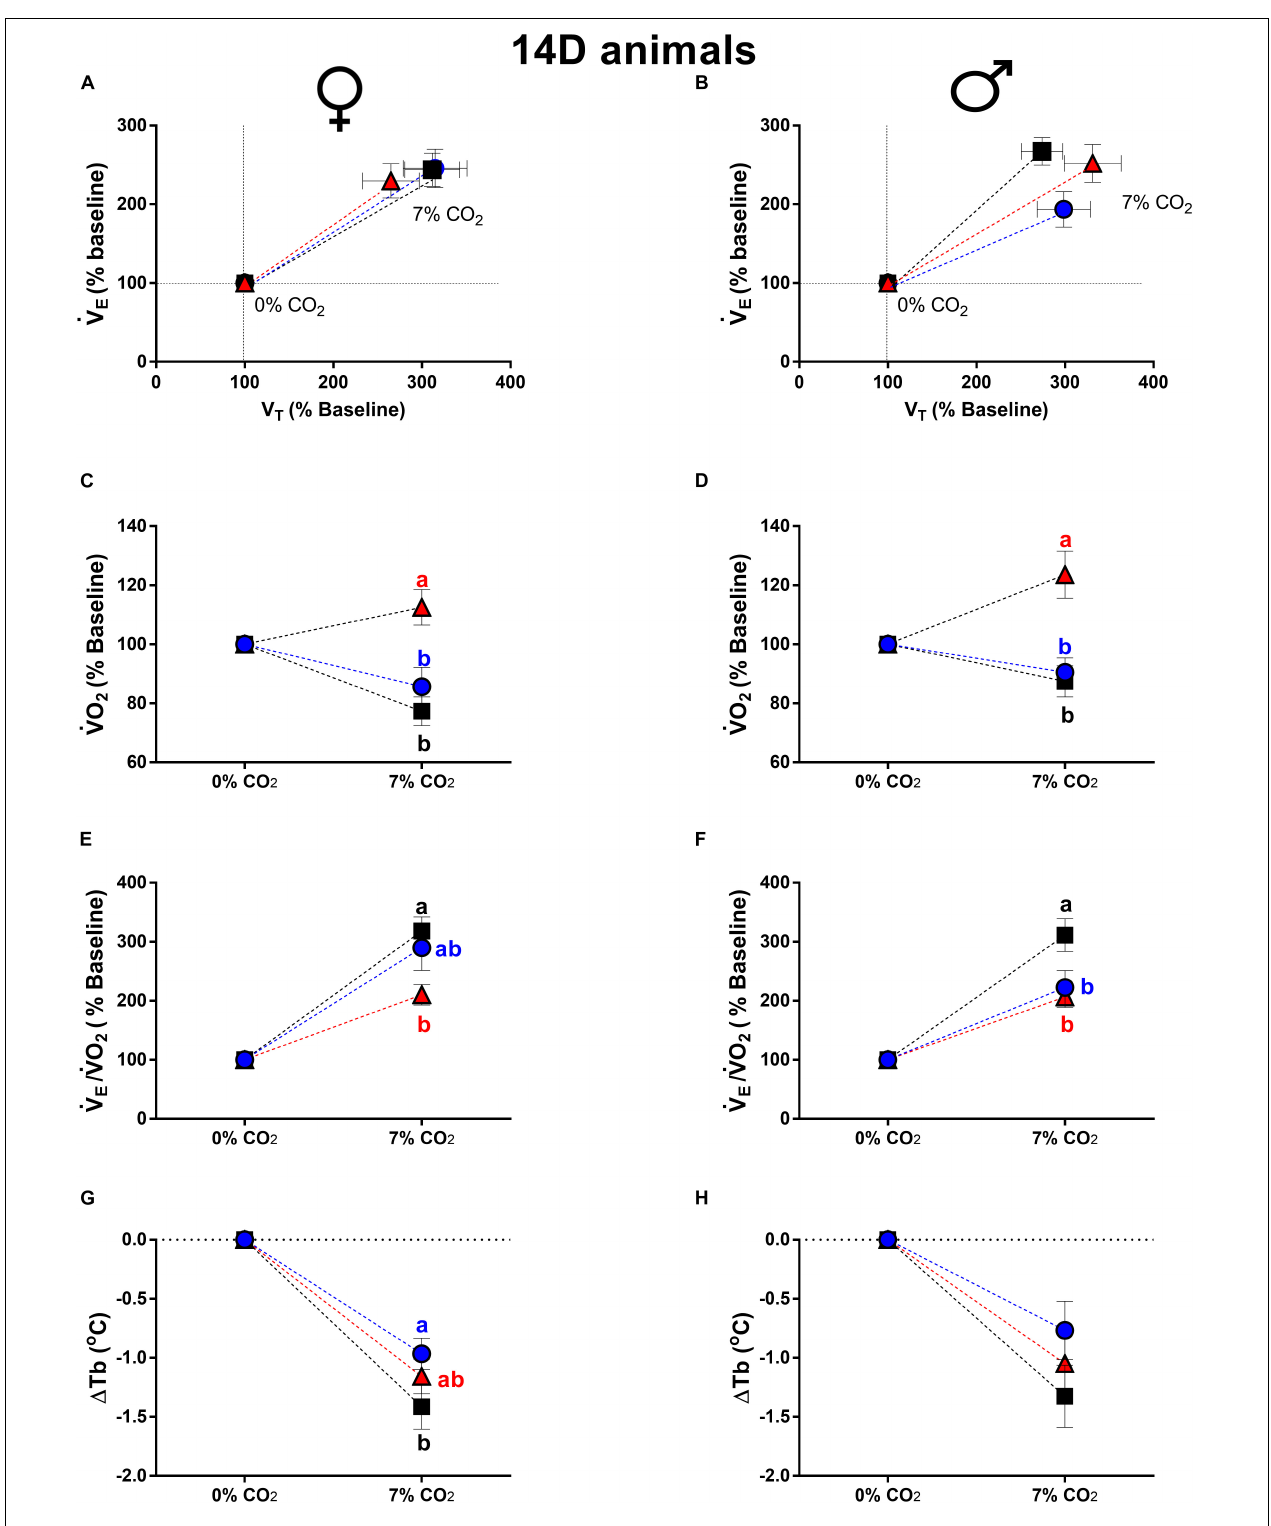
FIGURE 2 | Breathing pattern (A,B) , oxygen consumption ( ˙ V O 2 ) (C,D) , air convection requirement ( ˙ V E / ˙ V O 2 ) (E,F) and body temperature (Tb) (G,H) , during normocapnia and hypercapnia of 14-days-old female and male chickens submitted to the experimental treatments during incubation, i.e., control temperature (CT, 37.5 ◦ C), low temperature (LT, 36 ◦ C, 6 h/day, from 0 to 5th day) and high temperature (HT, 39 ◦ C, 6 h/day, from 0 to 5th day). Values are expressed as mean ± SEM. Different letters represent statistical differences among the treatments. Level of significance: P ≤ 0.05.